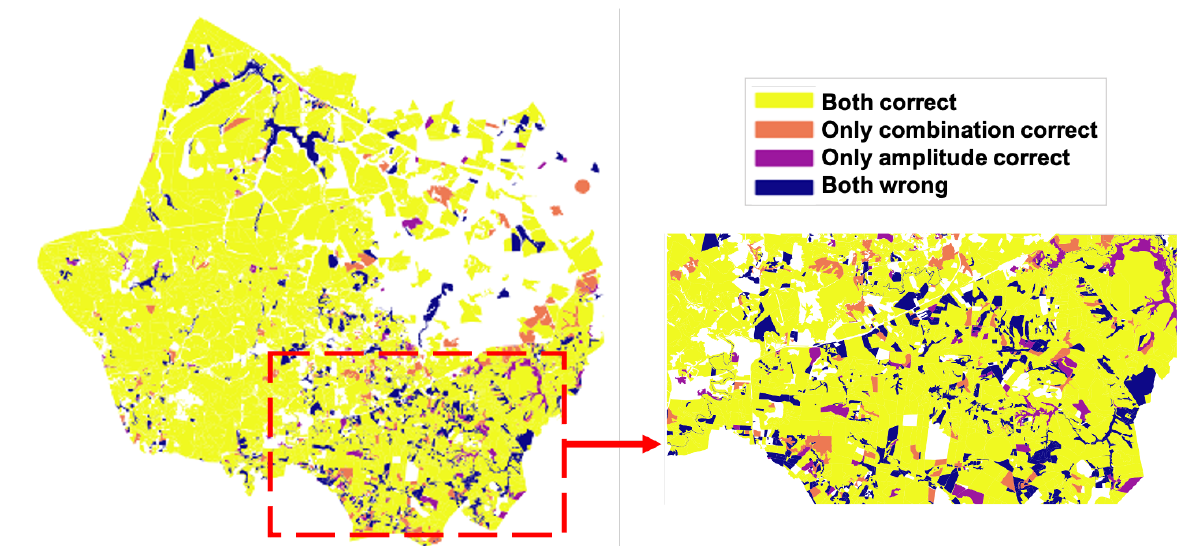
Figure 10. Representation of match and mismatch, with respect to the ground truth, for the SVM-based maps obtained from intensity only and from the combination of intensities and